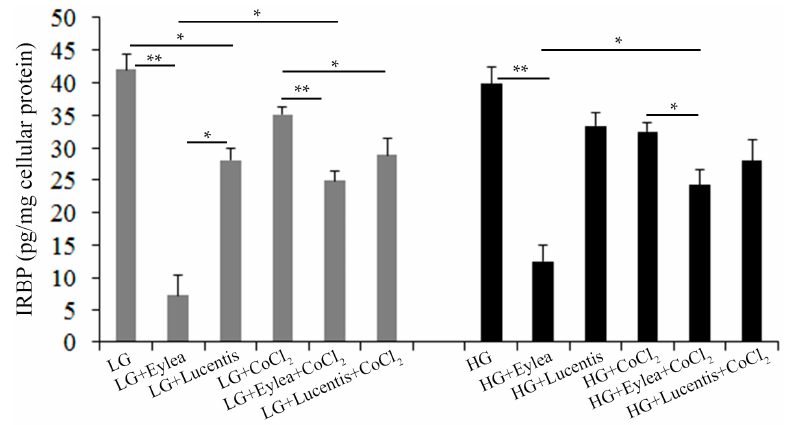
Figure 9. Aflibercept and ranibizumab inhibited IRBP production in Y79 photoreceptor cells. IRBP was measured by ELISA using conditioned media collected from Y79 cells 24 h after incubation in stress media containing 1% FCS. * p < 0.05 and ** p < 0.01, n = 5/group.